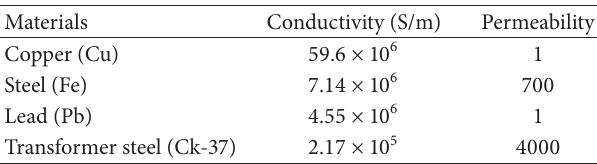
Table 1: Properties of various materials.